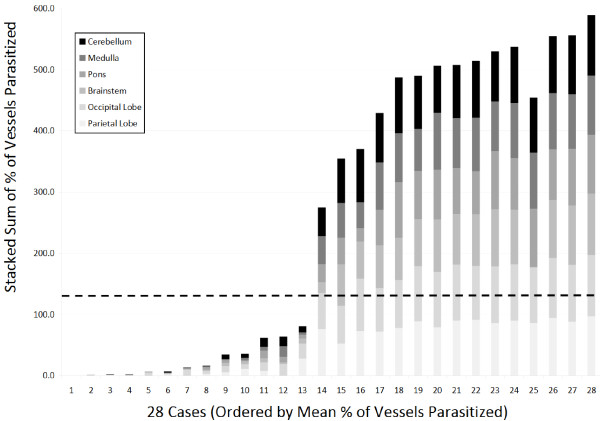
The distribution across 28 sequential cases of vessel sequestration (as measured by % of vessels parasitized) across six sites within the brain are shown as stacked bars (maximum = 600 represented 100% of vessels parasitized × 6 sites). Cases are ordered by mean % of vessels parasitized. The dotted horizontal line represents the overall cut off for “cerebral malaria” (23.3% × 6 sites = 139.8) and demonstrates that, for total brain quantification, there is a clear cut-off between controls (non-cerebral malaria, cases 1–13) and cases (cerebral malaria, cases 14–28).